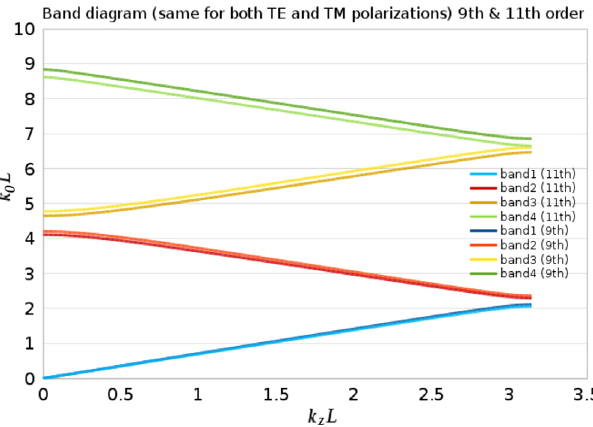
Figure 6. Band diagrams for 9th and 11th order by